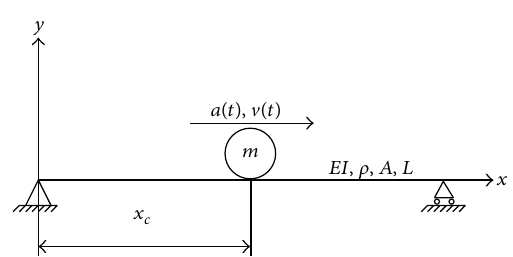
Figure 1: Schematic figure of a Timoshenko beam and a moving mass system.